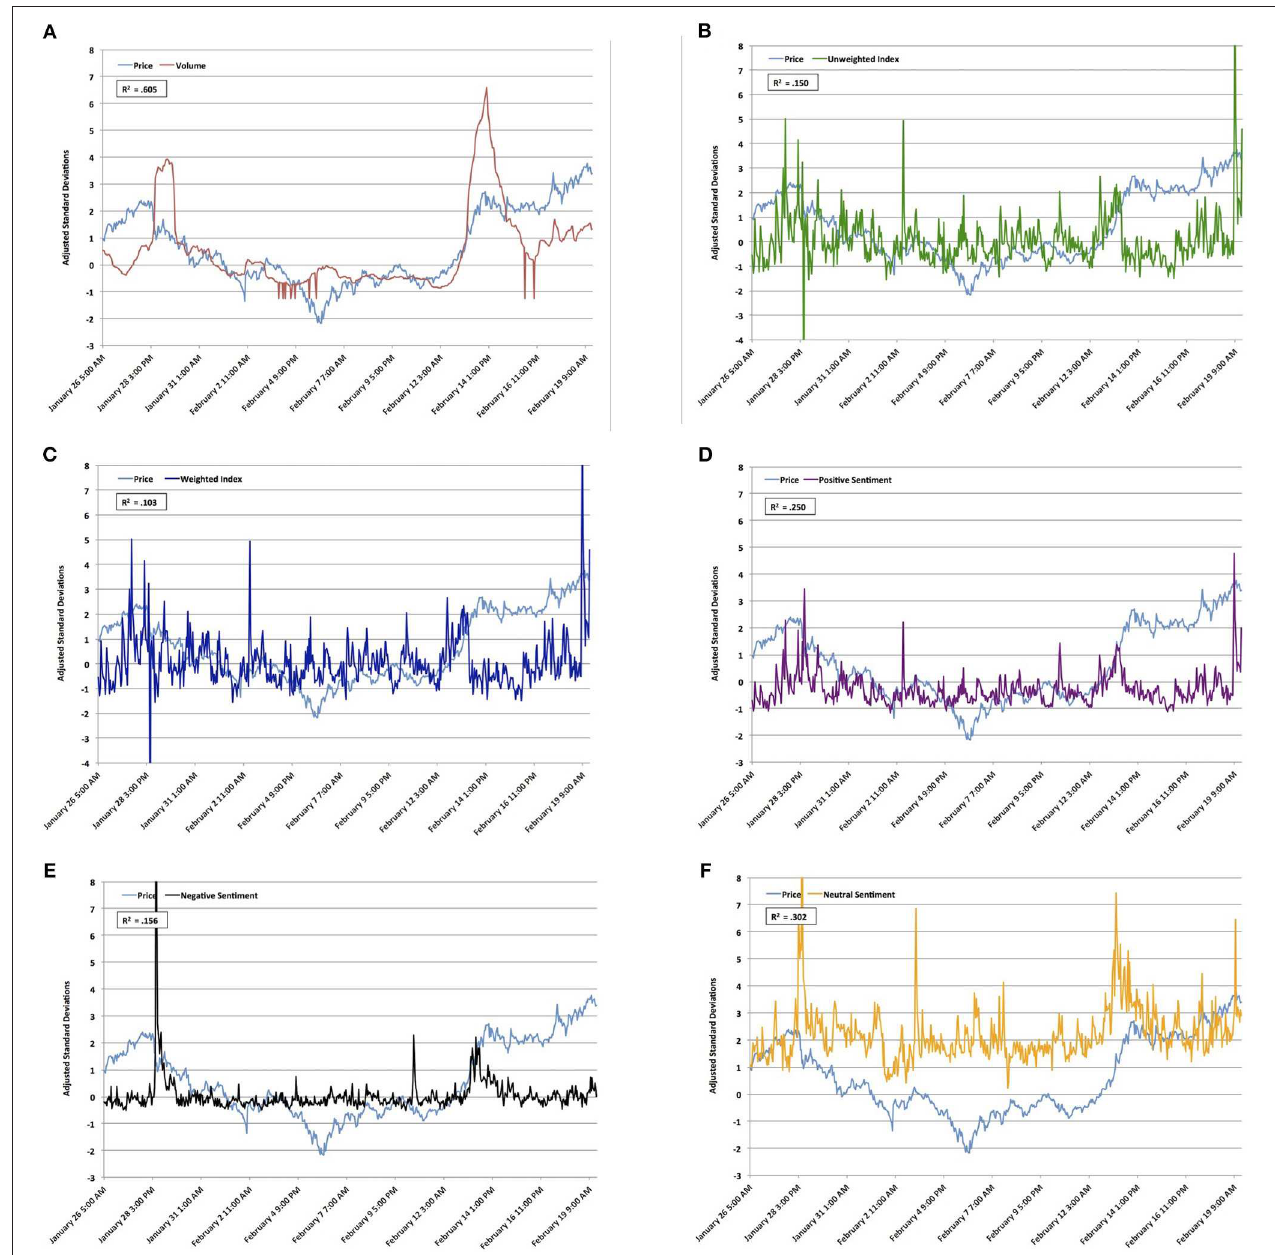
FIGURE 1 | Shown are the price fluctuations vs. our chosen six features, respectively, over the time period under consideration: (A) Price vs. Volume, (B) Price vs. Unweighted Index, (C) Price vs. Weighted Index, (D) Price vs. Pos. Sentiment, (E) Price vs. Neg. Sentiment, and (F) Price vs. Neutral Sentiment. These six features proved to be varied enough to train the model effectively on a variety of different trading points and resulted in the best and most accurate overall correlation with the testing data, as summarized in Table 3